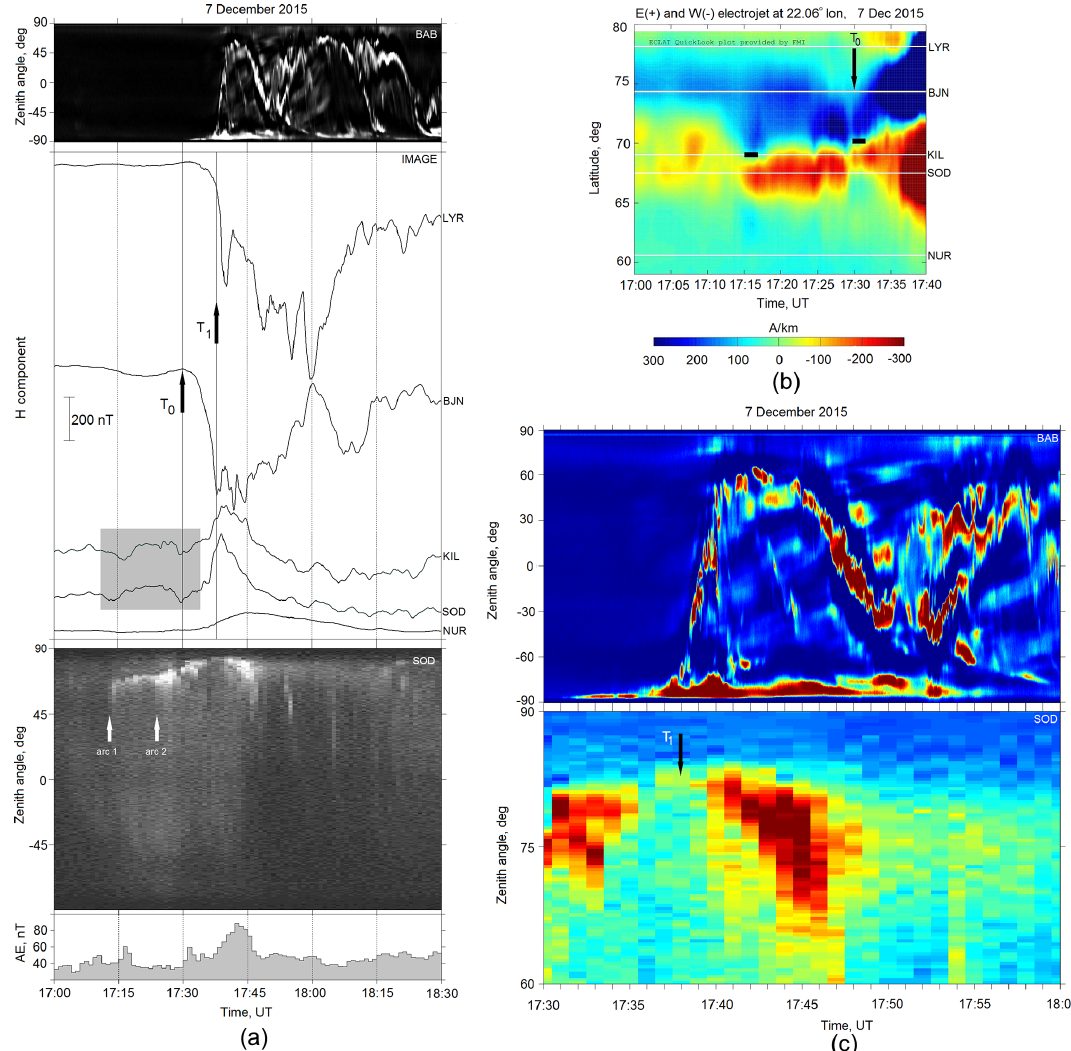
Figure 2. (a) Keograms showing aurora dynamics over Barentsburg (BAB) and Sodankylä (SOD) and magnetic activity on the ground, as inferred from five observatories of the IMAGE magnetometer network and Auroral Electrojet (AE) index. (b) Dynamics of equivalent ionospheric currents; westward and eastward electrojets are indicated with gradations of blue and red, respectively, and white horizontal lines show the latitude of the observatories. (c) Keograms of SOD and BAB at a higher temporal resolution in color. T 0 and T 1 are the times of onset and torch formation, respectively. Two negative variations in the H component are highlighted in